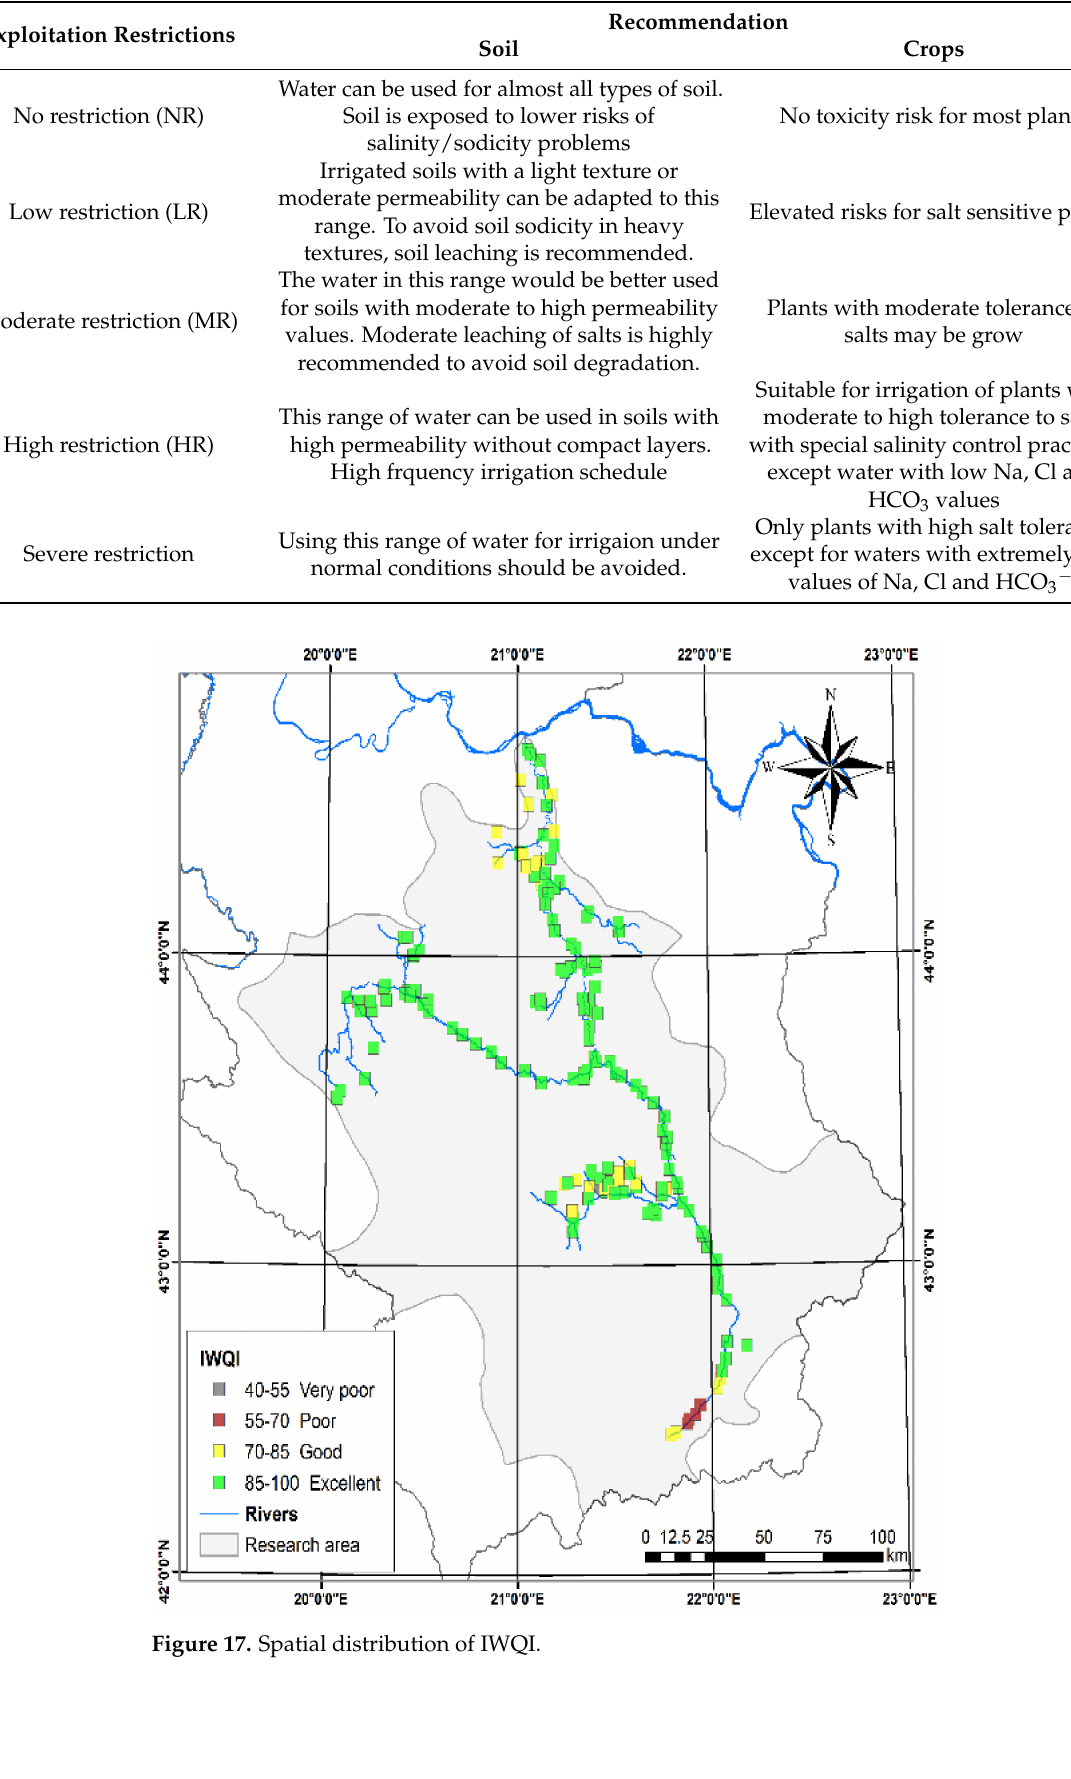
Table 5. Classification of water quality for investigated sites based on IWQI.